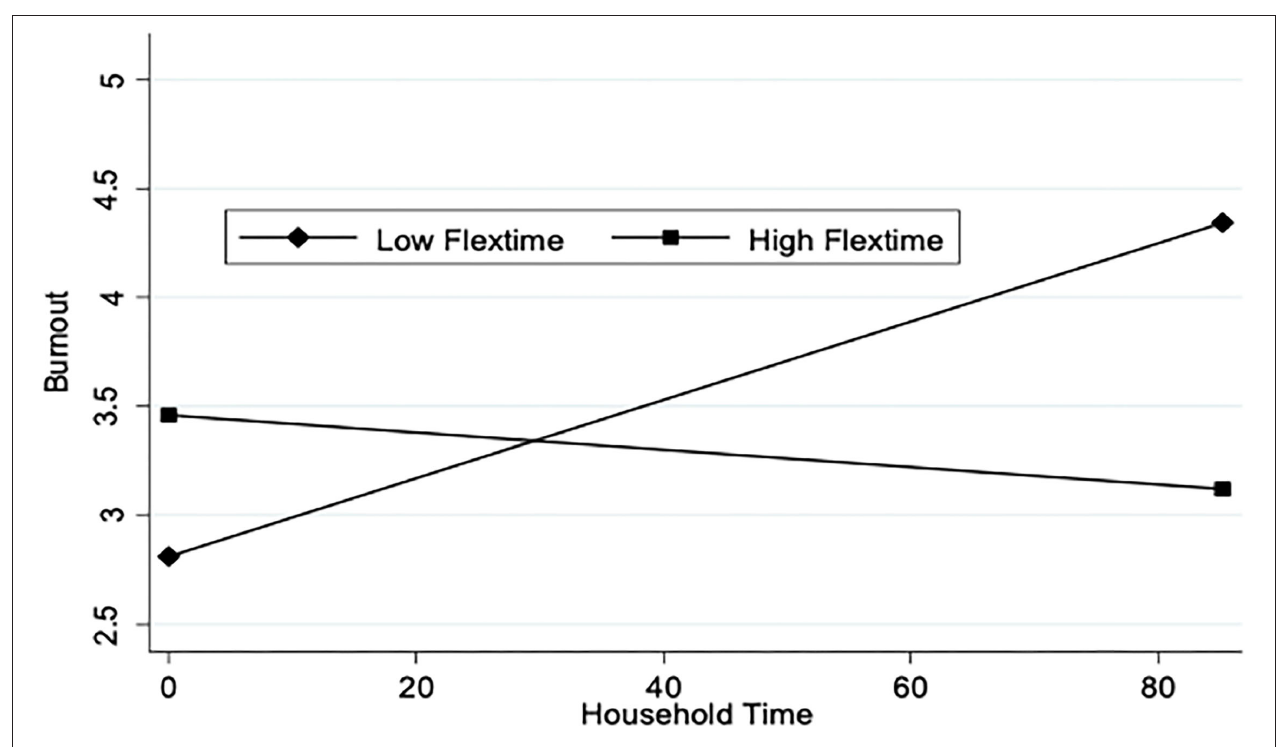
FIGURE 2 | Household time and predicted burnout by flextime.